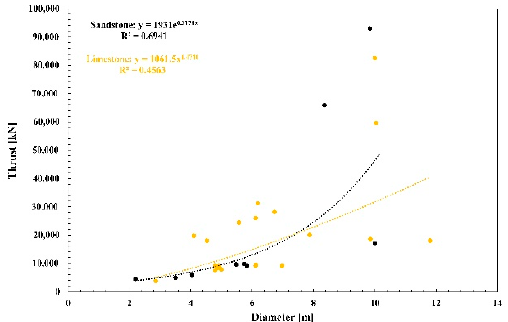
Figure 19. Correlation between the diameter and the thrust due to the excavation in sandstone and limestone by double shield TBMs.